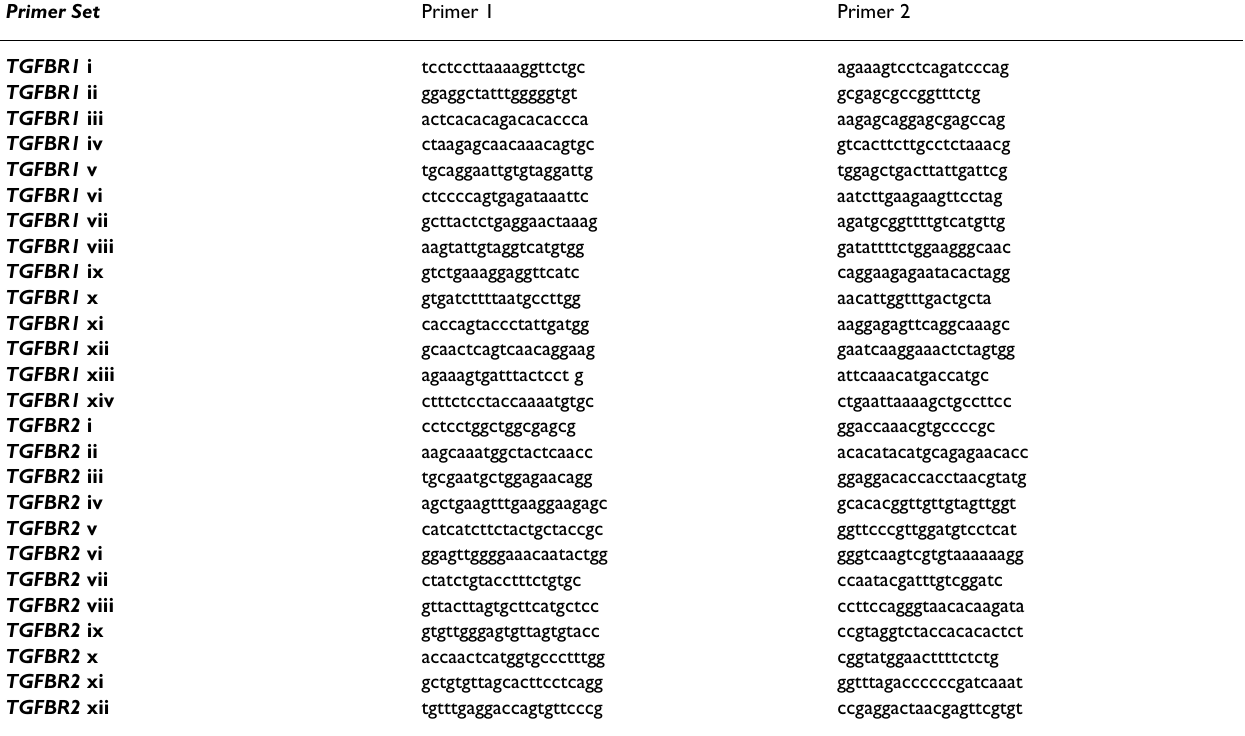
Table 2: Primer sequences used for screening TGFBR1 and TGFBR2 genes Primer